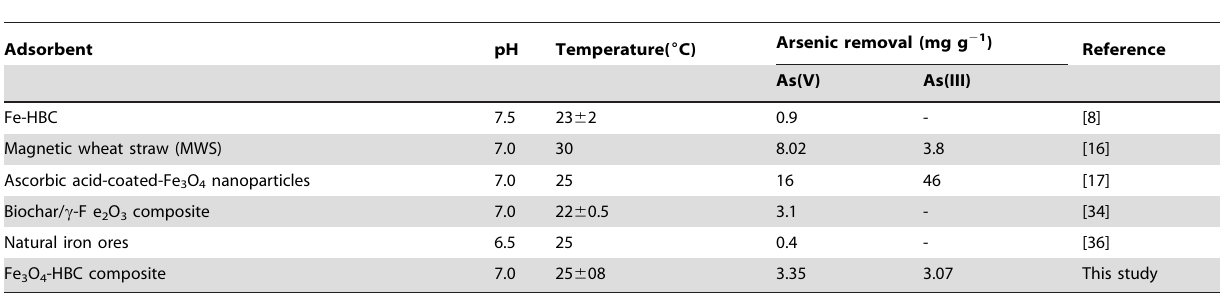
Table 4. Comparison of the adsorption capacities of different adsorbents for As(V) and As(III).